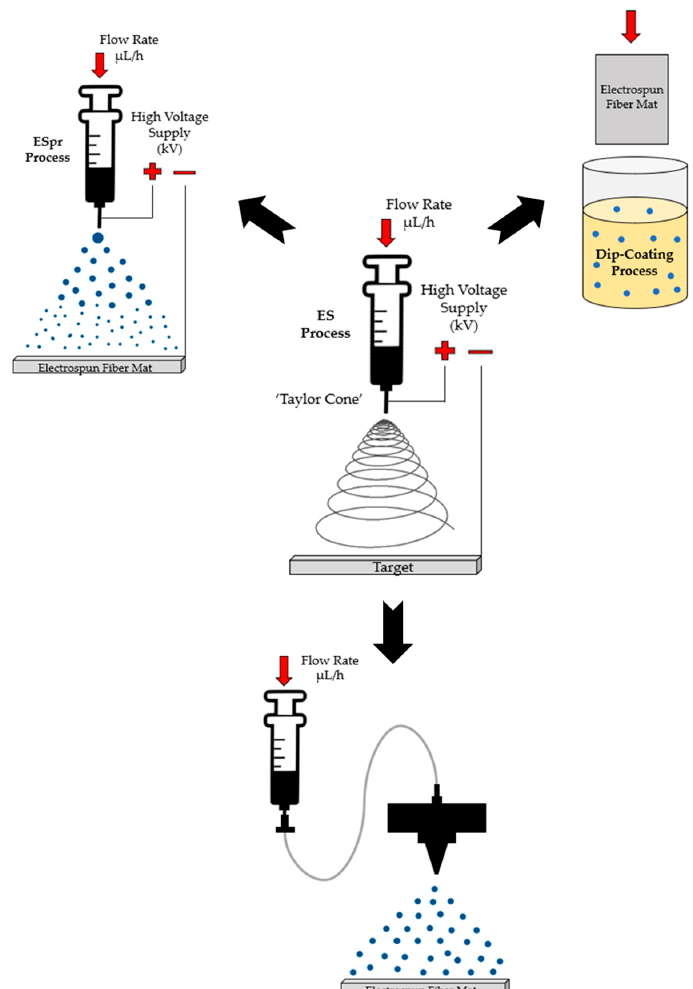
Figure 1. Schematic representation of the deposition techniques. Starting with the deposition of